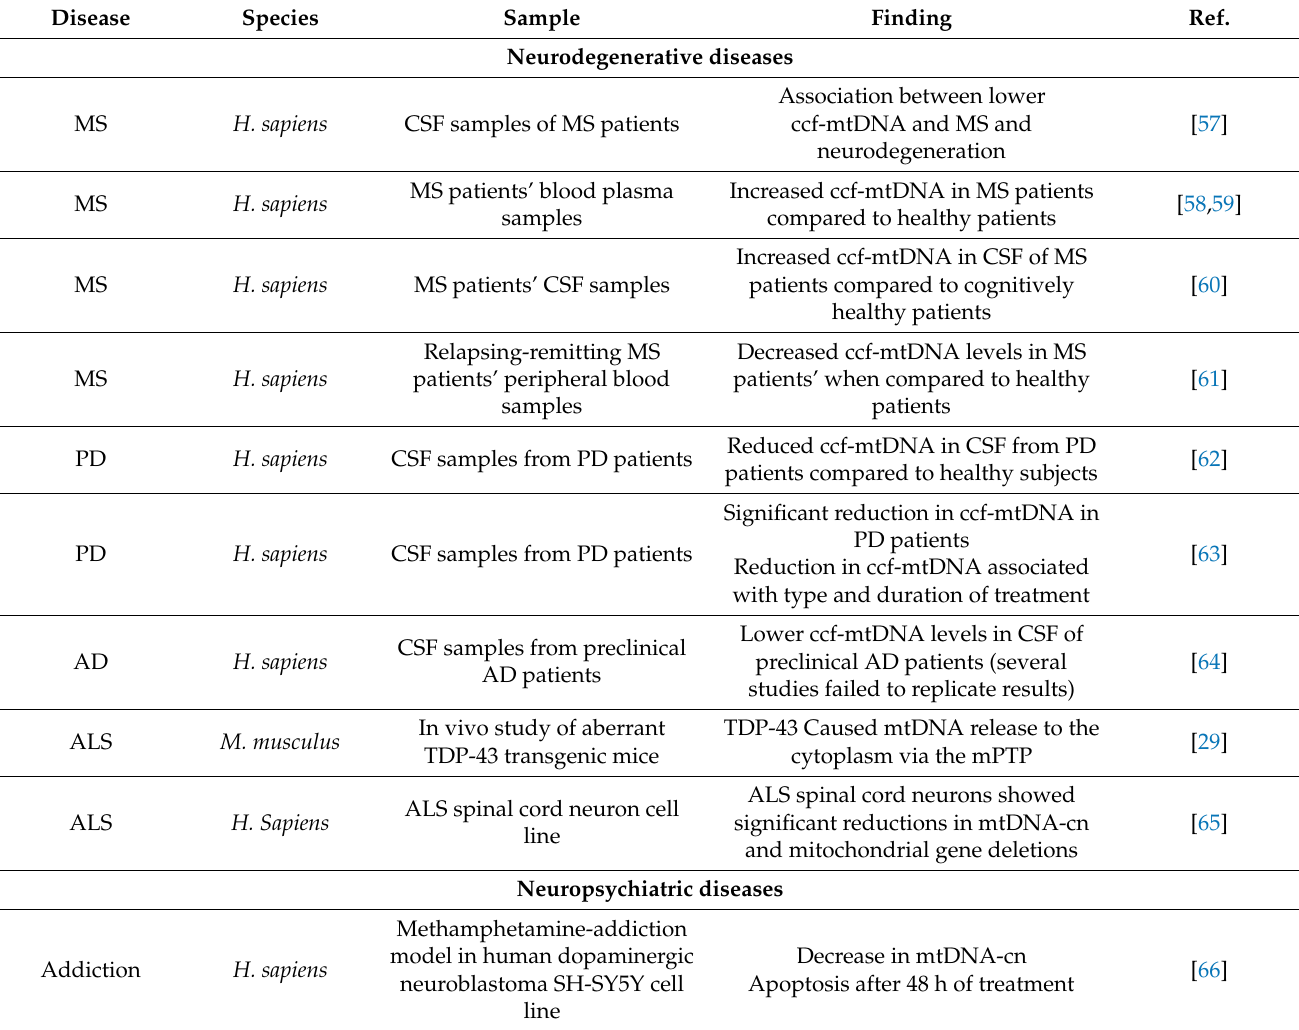
Table 1. A summary of studies measuring ccf-mtDNA or mtDNA copy number in neurological disorders.